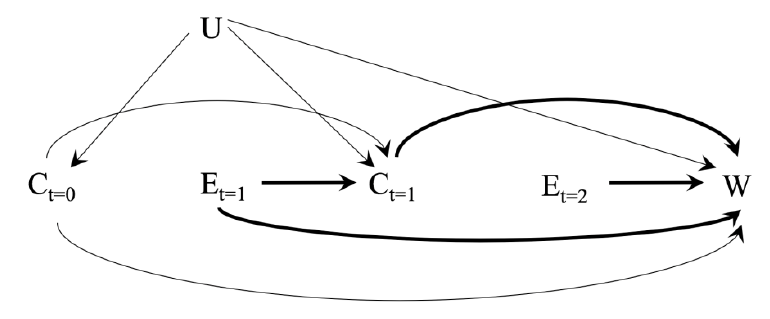
Figure 2 : Causal relations after inverse probability of treatment